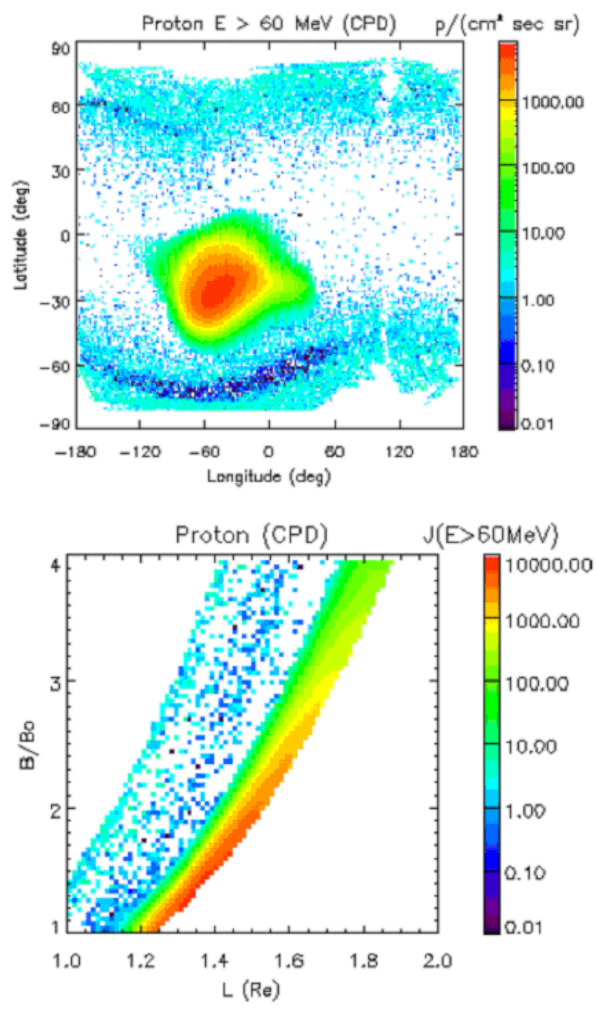
Fig. 4. Flux of energetic (E > 60MeV) protons measured by the CPD as a function of (a) the geographic (longitude, latitude) and (b) the (B, L)